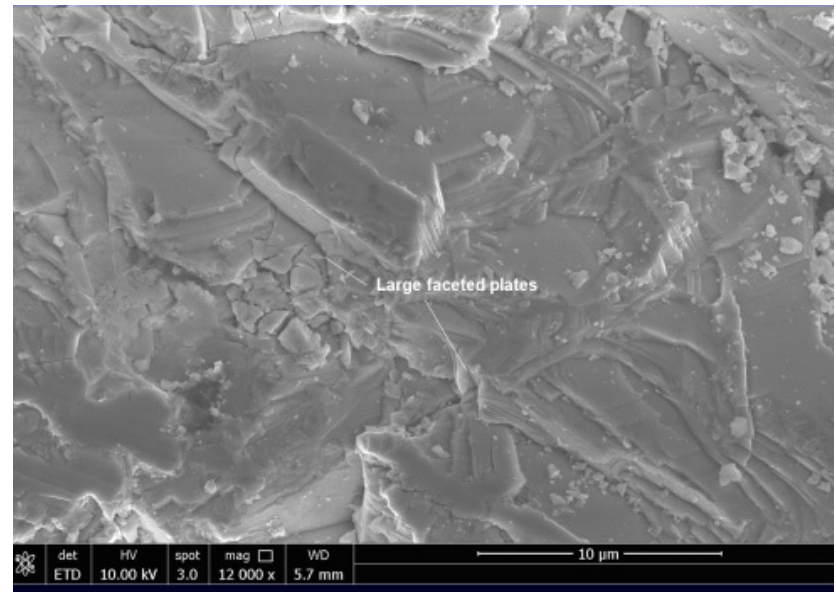
Figure 10. Micromorphology of Cr-ZnSe crystals, showing faceted plates, microcracks, and small crystallites of micrometer sizes.